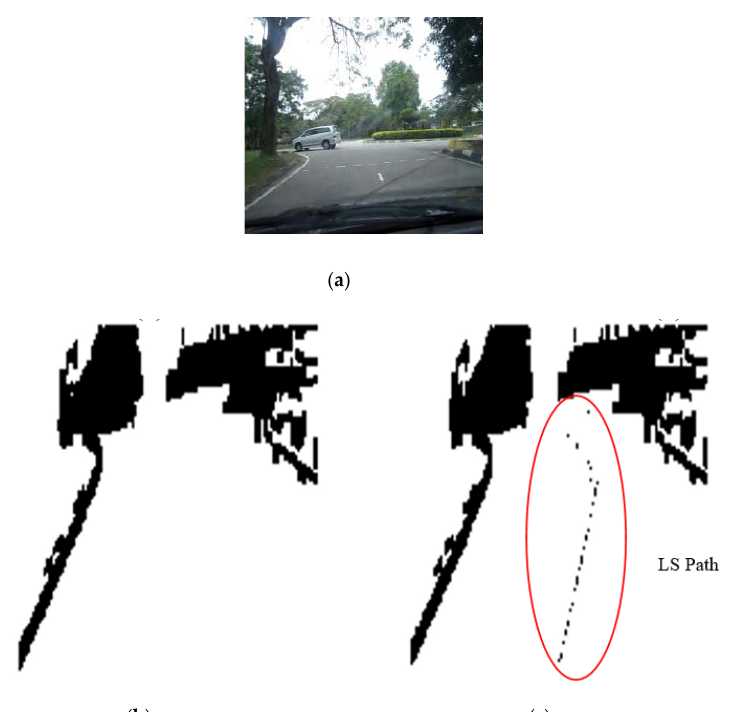
Figure 8. Image sequence with applying LS for roundabout determination at 10 m from the roundabout: ( a ) original image, ( b ) processing image, and ( c ) implementation of LS (continuous dotted line at the middle).